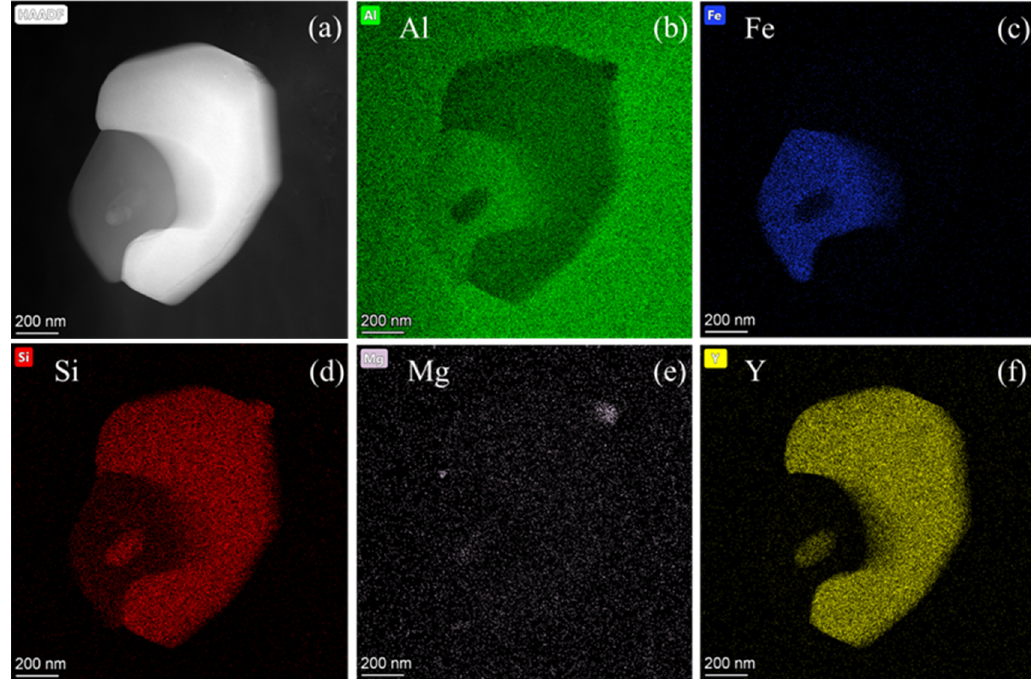
Figure 9. STEM-HAADF image and surface scanning distribution map of intragranular particles of a typical sample (480 °C/0.01 s −1 ) after hot compression: ( a ) STEM-HAADF image of intragranular particles; ( b – f ) surface scanning distribution of elements Al, Fe, Si, Mg, and Y.